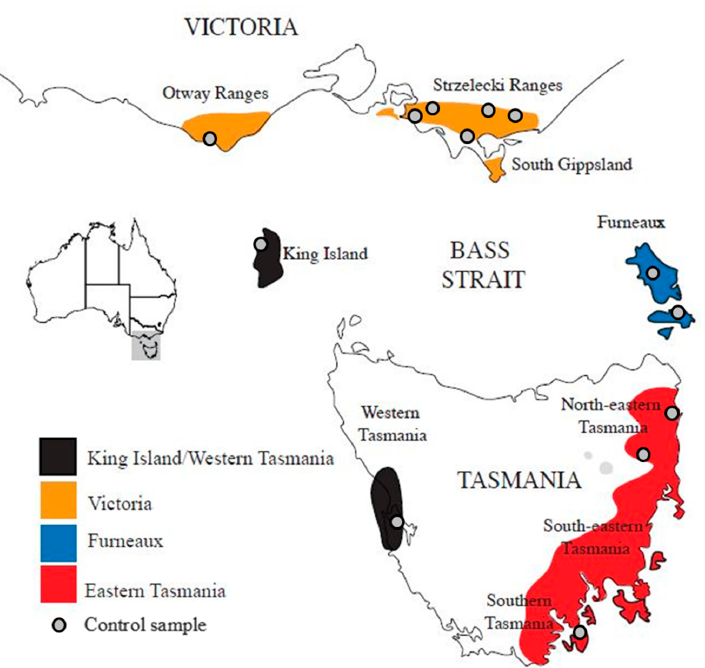
Figure 3. Map of southeastern Australia showing the approximate native range of Eucalyptus globulus (shaded in grey in insert map of Australia). The four geographic regions (Victoria, Furneaux, King Island/western Tasmania and eastern Tasmania) into which the 590 native samples with nuclear microsatellite data were allocated for the STRUCTURE analysis are shown. The specific locations of the 13 control samples used to align the microsatellite scores of the Californian landrace samples with the native range are shown. The map is modified from Jordan et al. [67] .